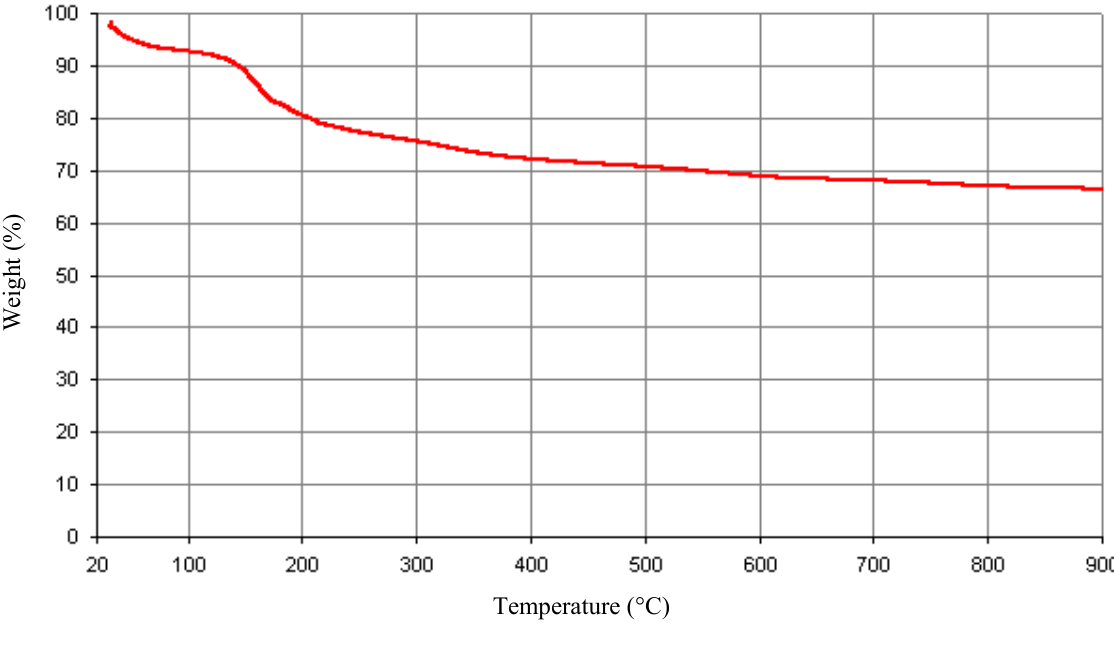
Figure 5. Thermogravimetric analyses of the purified bioflocculant.